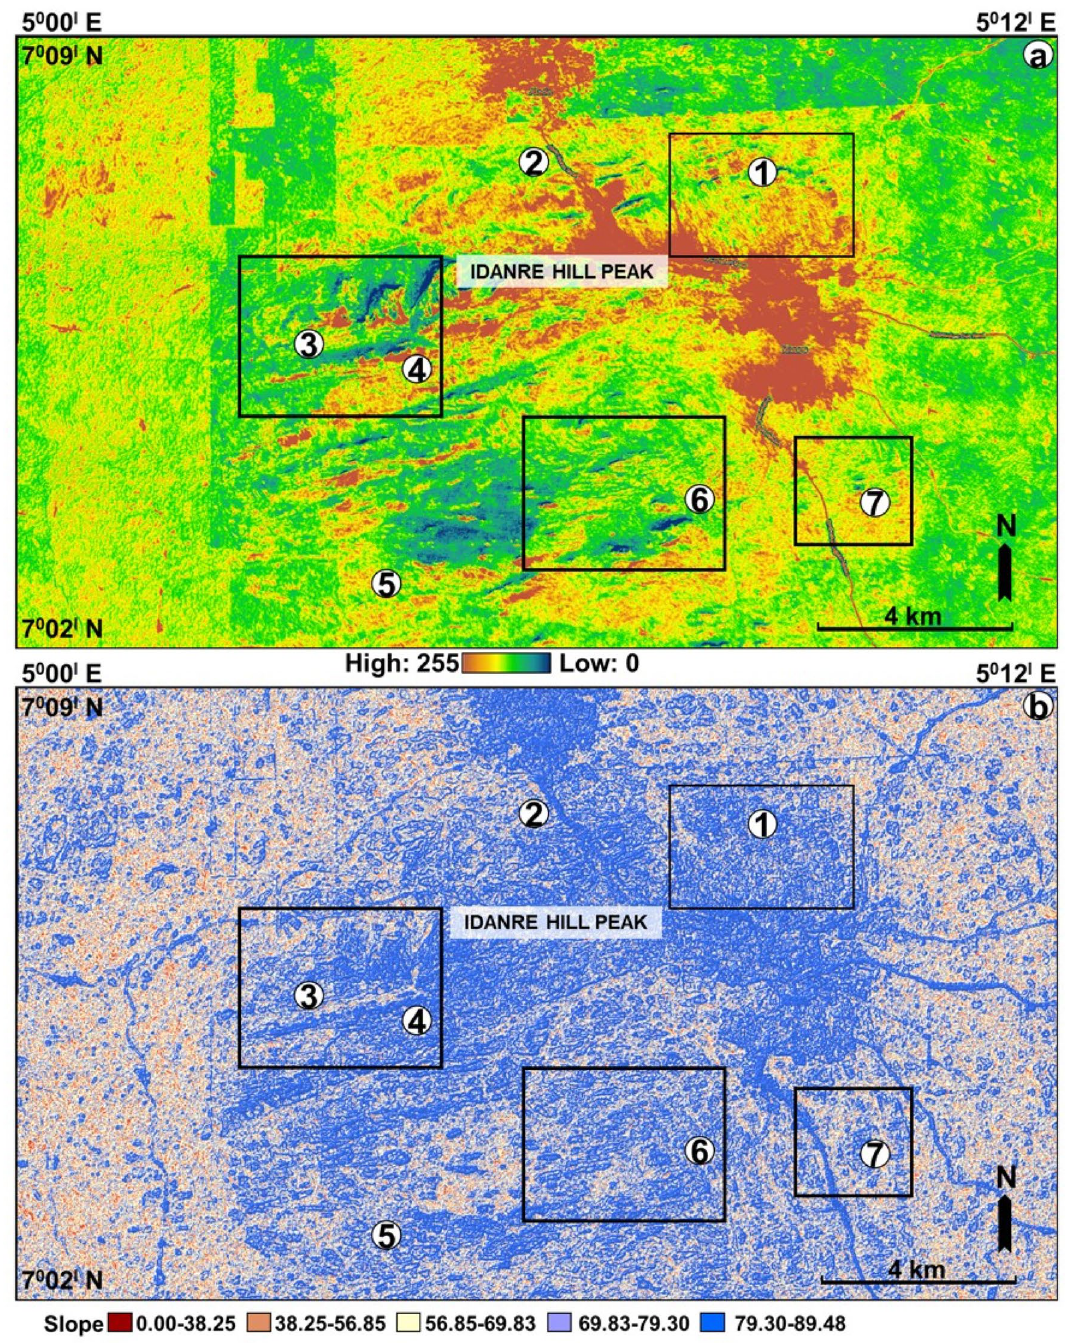
Figure 6. ( a ) Elevation map of the study area as rasterized from the google earth DSM in Fig. 2a. ( b ) Slope attribute as derived from the spatial analysis tool in ArcGIS. The map is used to identify changes in slope (gradient or steepness) within the study